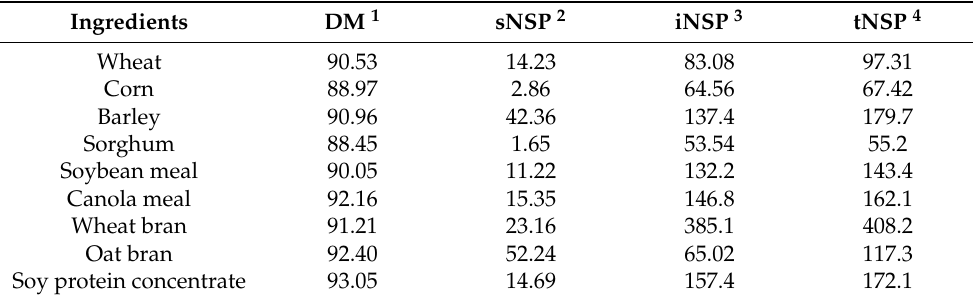
Table 1. Content of dry matter (g/100 g, as is basis) and non-starch polysaccharides of the plant-based ingredients used in the study diets (g/kg, as is